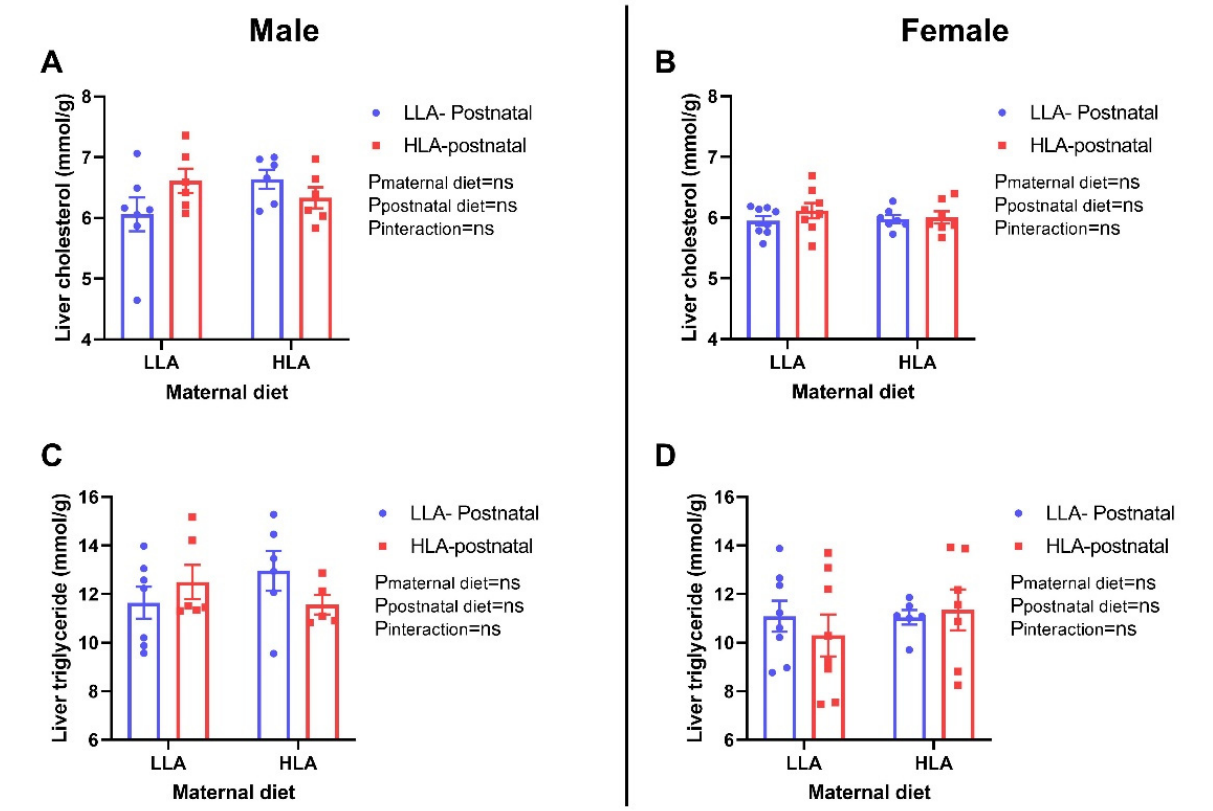
Figure 9. Effect of a maternal and postnatal diet high in linoleic acid on lipid concentration in the liver of adult offspring. Data are presented as mean ± standard error of the mean (SEM). Two-way ANOVA was performed for statistical analysis with maternal diet and postnatal diet as two factors. n = 6–8. LLA: low linoleic acid; HLA: high linoleic acid; PN: postnatal. A : Liver cholesterol concentration male; B : Liver cholesterol concentration female; C : Liver triglyceride concentration male; D : Liver triglyceride concentration female.